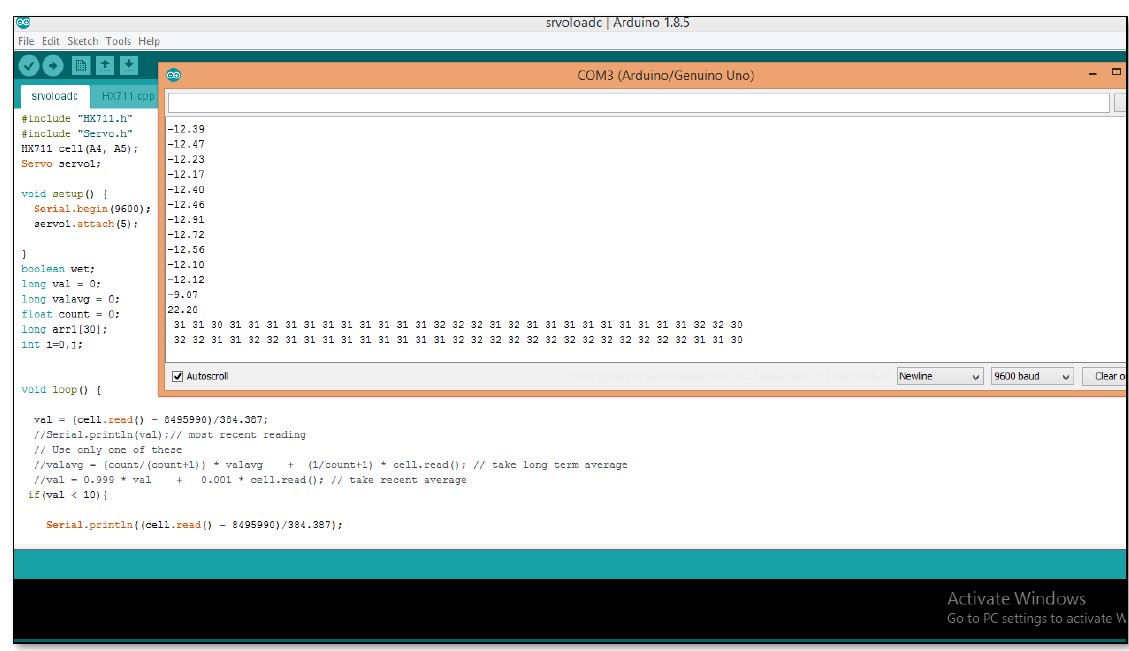
Figure 16. Weight detection for waste segregation.